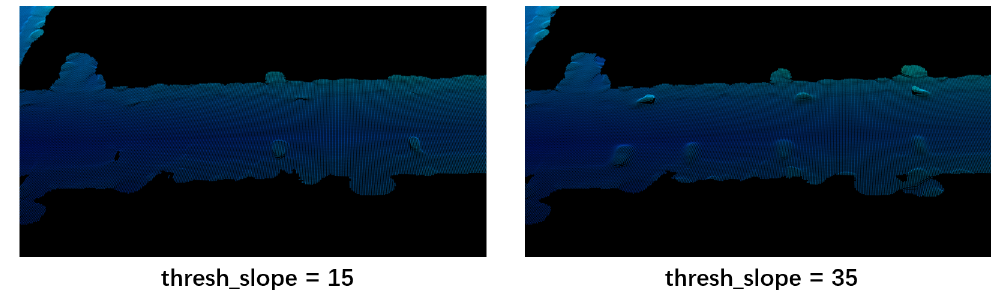
Figure 15. Terrain modeling results by setting thresh _ slope to different values.